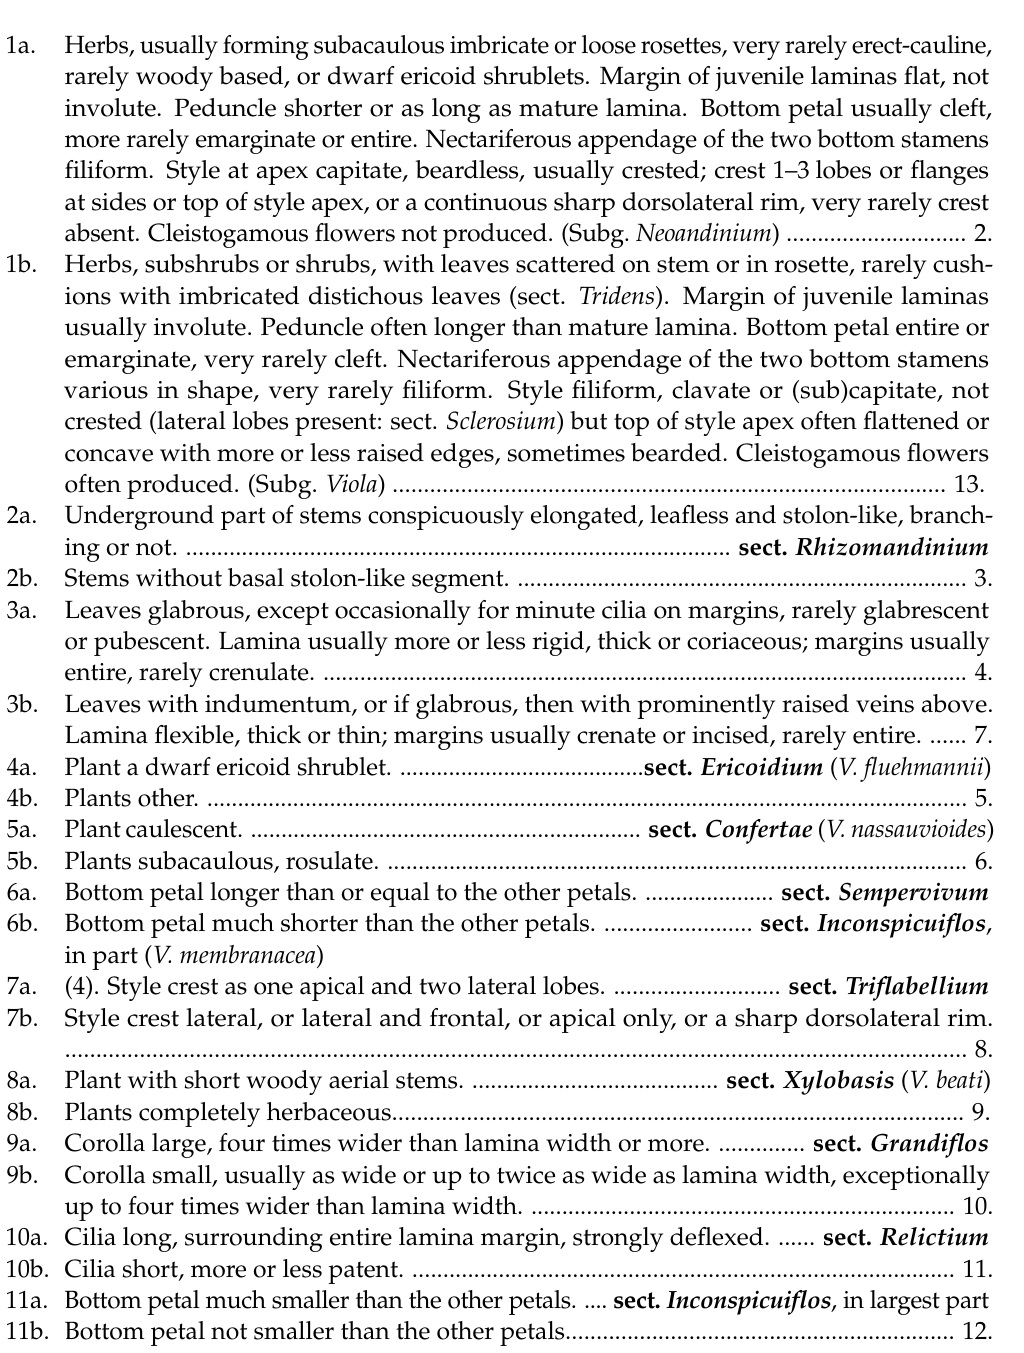
rarely woody based, or dwarf ericoid shrublets. Margin of juvenile laminas flat, not involute. Peduncle shorter or as long as mature lamina. Bottom petal usually cleft, more rarely emarginate or entire. Nectariferous appendage of the two bottom stamens filiform. Style at apex capitate, beardless, usually crested; crest 1–3 lobes or flanges